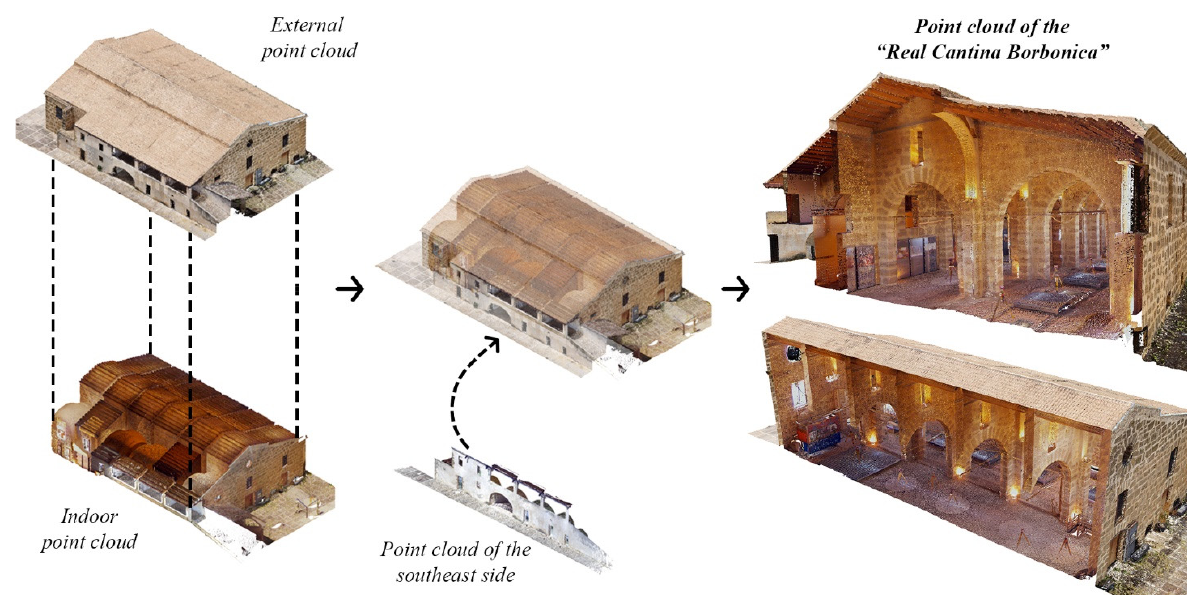
Figure 10 . Point cloud of the “ Real Cantina Borbonica